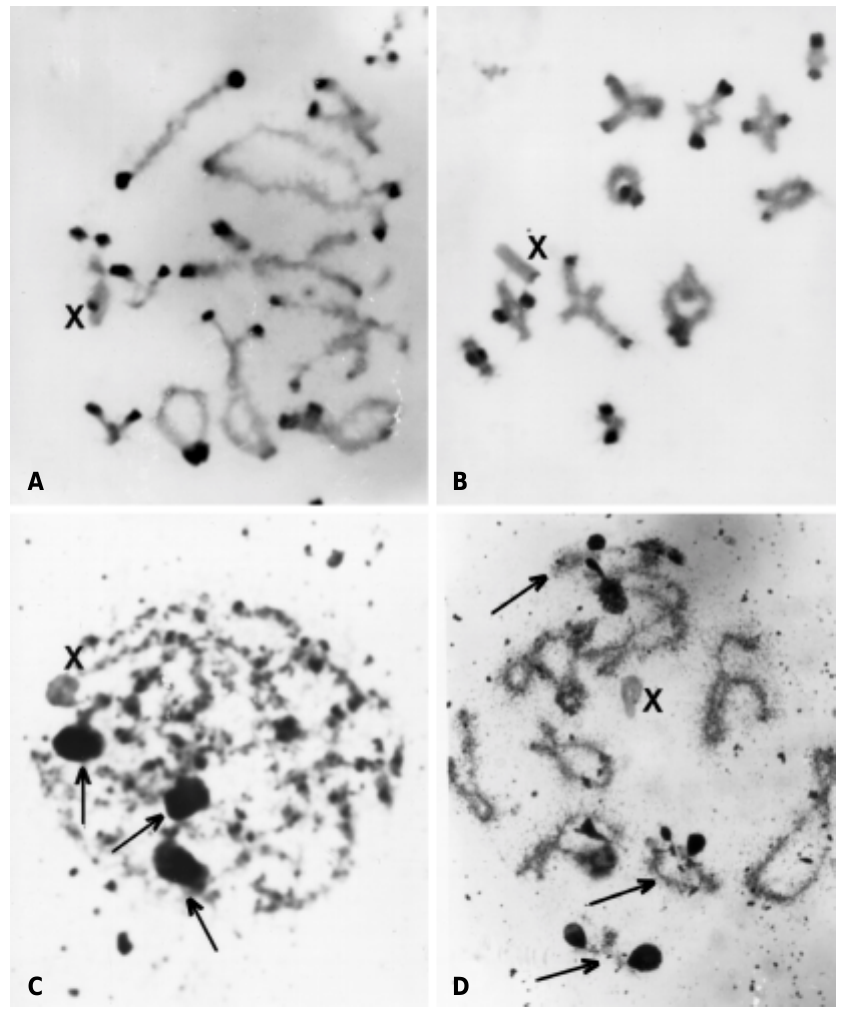
Figure 2 - A,B ) Cells in diplotene showing the C-banding pattern of B. coccineipes. A ) Initial diplotene and B ) final diplotene. C,D ) Nucleolar organizer regions (NORs) stained with silver nitrate in meiotic chromosomes, C ) zygotene and D ) initial diplotene. The nucleolar remnants associated with the bivalents S , S and S are indicated by arrows. X represents the X 9 10 11